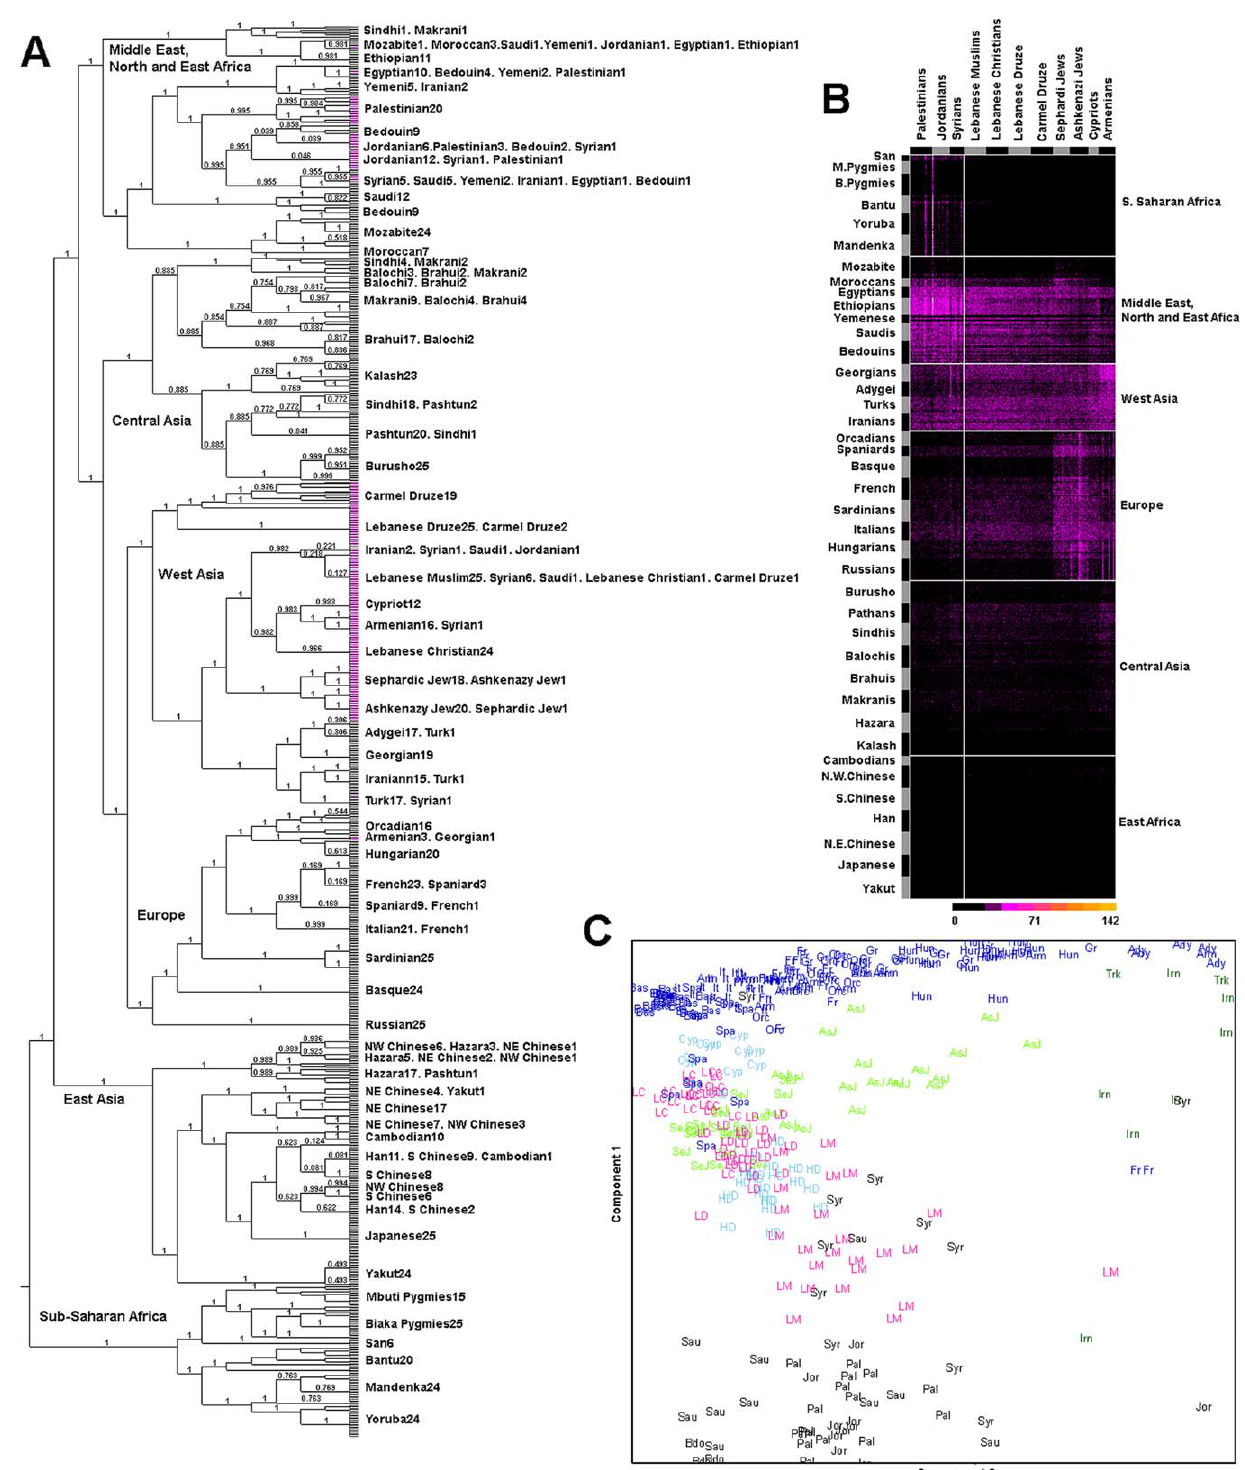
Figure 3. Population relationships from genome-wide haplotypes. A) Each tip of the tree corresponds to an individual; numbers of individuals are shown next to their population name at the tip of the branches. Numbers on branches show partition posterior probability. The Levantine populations’ tips are highlighted in pink. B) Raw coancestry matrix shows relationships between the Levantines and the world populations. Intensity of the colors reflects the number of haplotype chunks donated to the Levantines. The vertical line is a visual aid to reflect the Levantine split observed in the tree. Horizontal lines distinguish the major geographic regions. C) Principal component analysis using the world coancestry matrix, figure is magnified on West Asia.